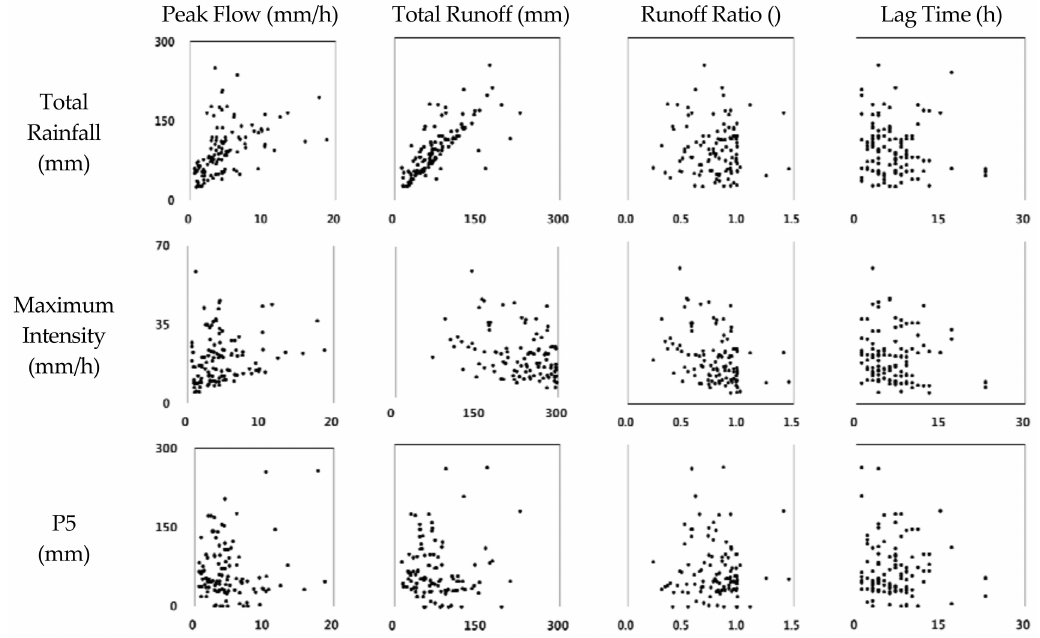
Figure 3. Scatterplots of the flood characteristics of the 113